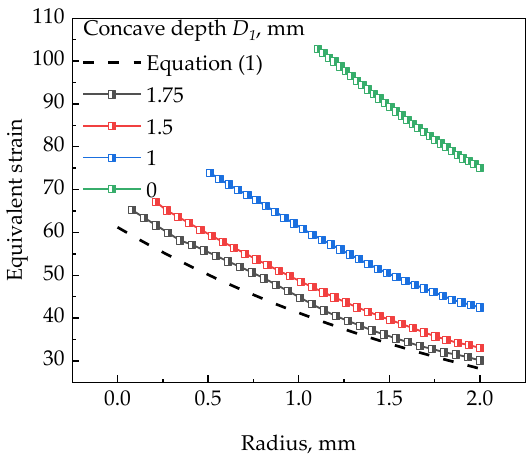
Figure 10. Equivalent plastic strain distributions along the radial direction in the mid-plane at the concave depth of 1.75, 1.5, 1 and 0 mm, in comparison with theoretical results.